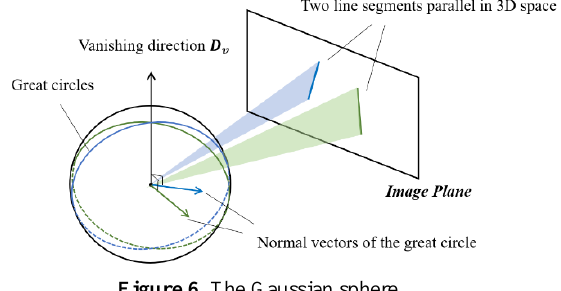
Figure 6 . The Gaussian